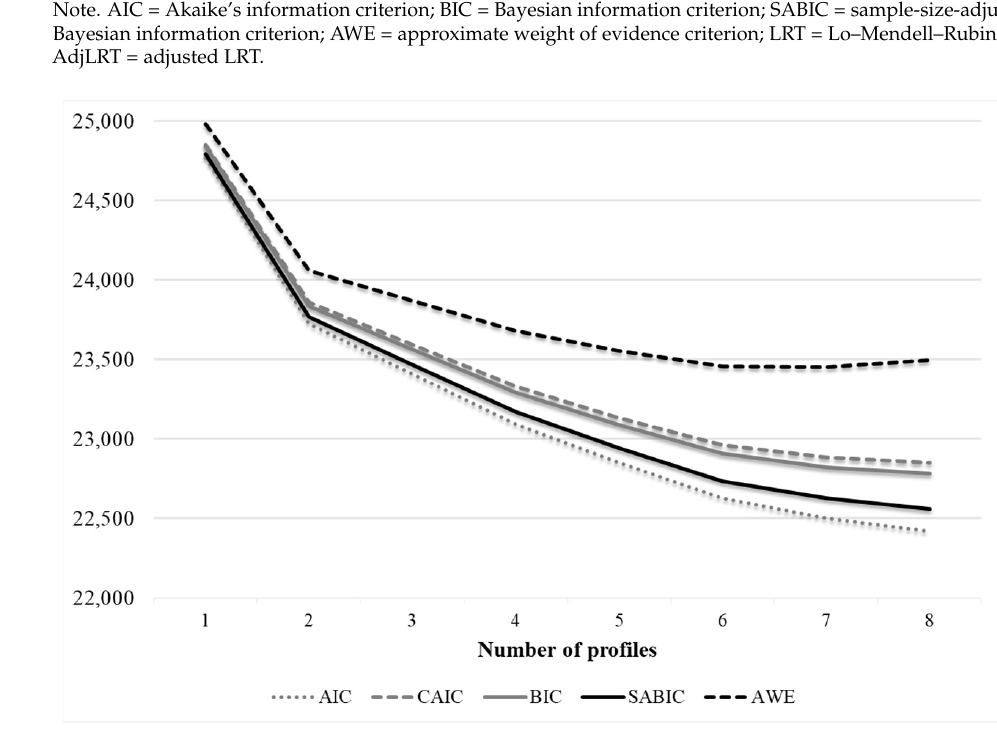
Figure 1. Elbow plot for the information criteria. Note. The number of profiles extracted in an LPA model are on the X-axis and the fit statistics are on the Y-axis.